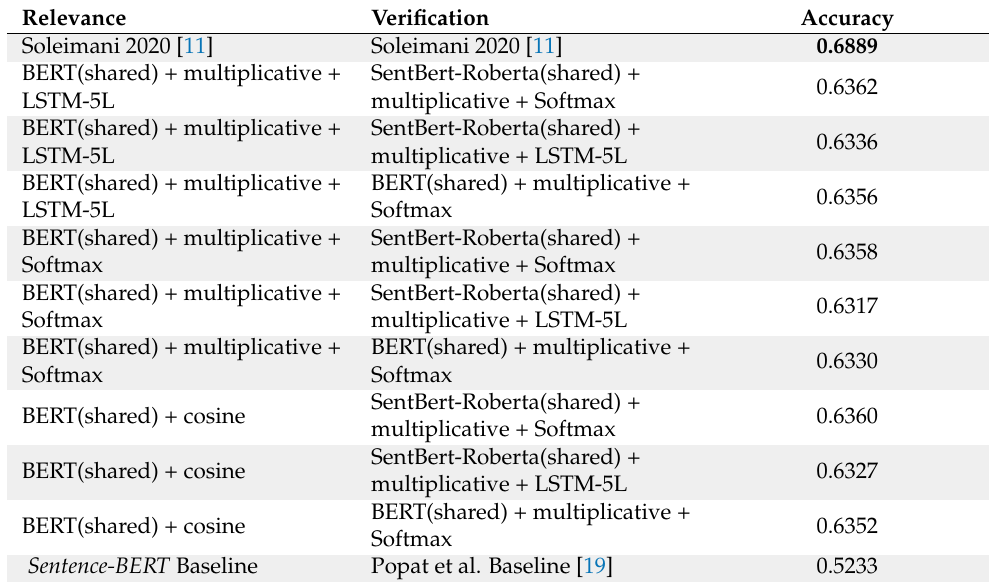
Table 4. Complete method evaluation. Accuracy of final claim classification is